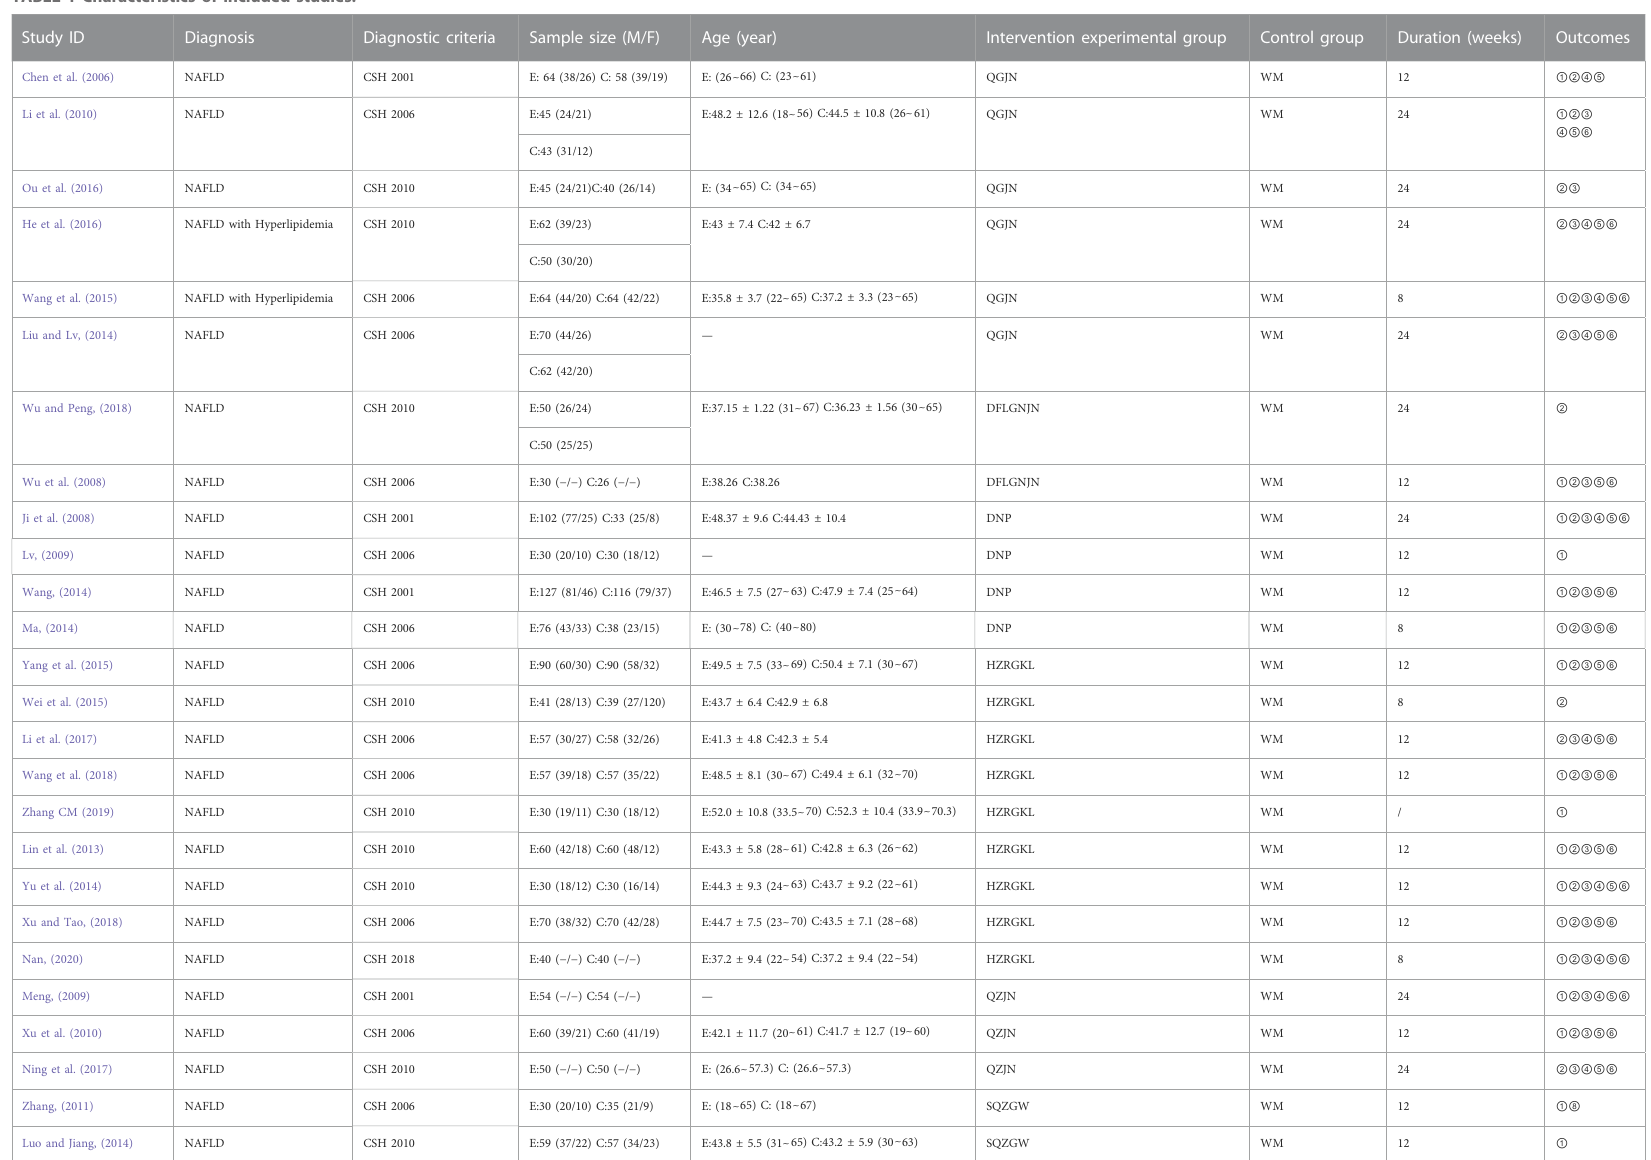
TABLE 1 Characteristics of included